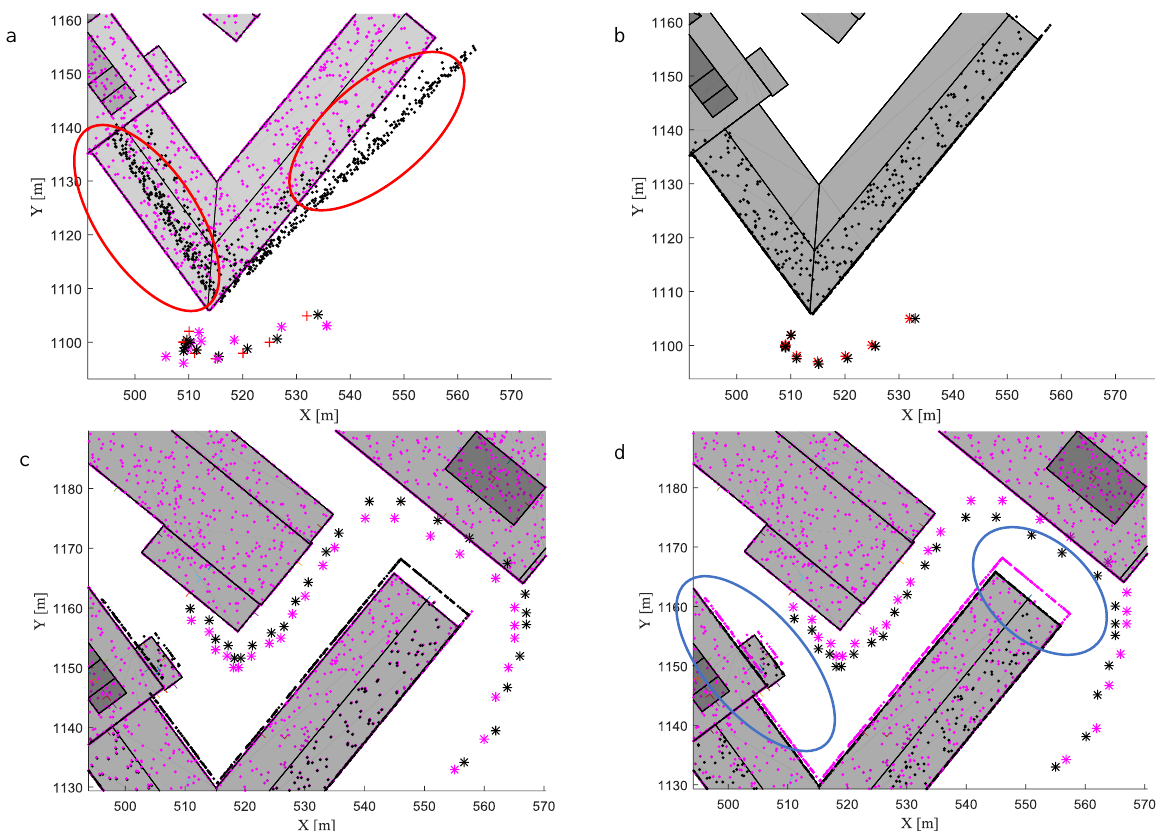
Figure 3: Results of adjustment after different processing steps. Black dots: estimated points: black asterisks: estimated camera positions; magenta: initial positions of points (dots) and camera positions (asterisks), typically the results of the previous step; red crosses: simulated noise-free camera positions. The building model is super-imposed to these results. a) Adjustment without planes (step 2); the initial values of the camera positions correspond to the GNSS positions. The red ellipses indicate deviations of the results relative to the building model. b) Adjustment with planes (step 4). c) Adjustment including new images (step 5) . d) Adjustment including new images and new planes (step 6). The blue ellipses highlight areas where the results of step 5 differ from the model and the adjusted black points coincide with a wall.